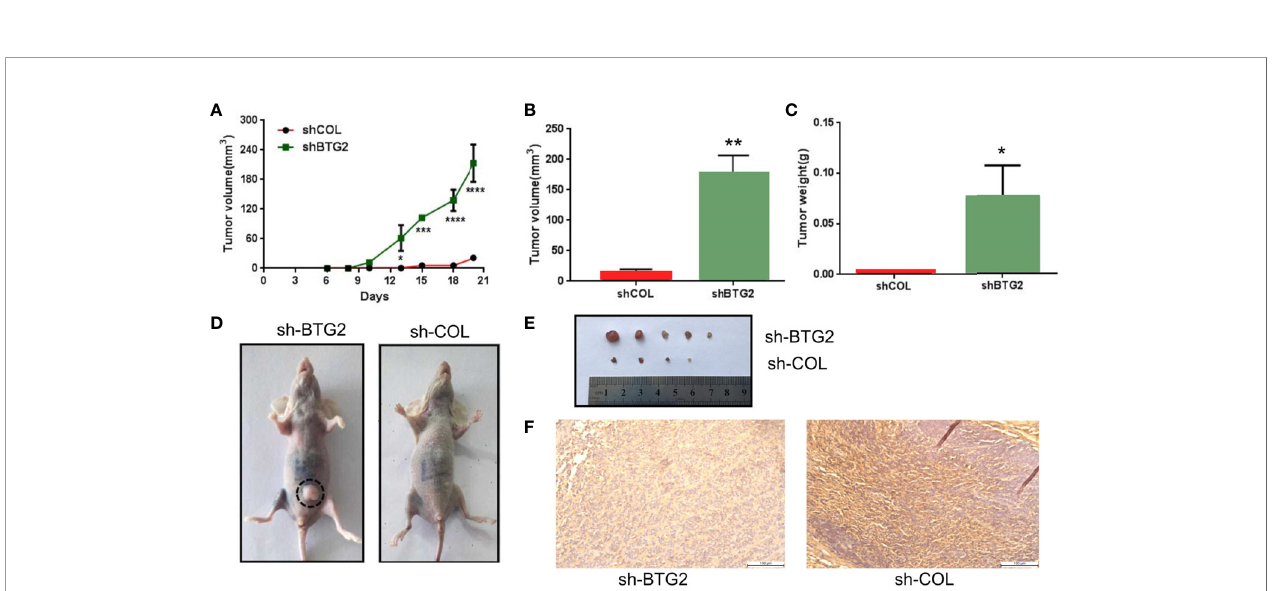
FIGURE 7 | BTG2 suppresses tumorigenicity in vivo and in clinic. (A) Tumor growth curve of BTG2 knockdown tumors (n = 5) and control tumors (n=5). (B) Analysis of tumor volume in BTG2 knockdown group and control group. (C) Analysis of tumor weight in BTG2 knockdown group and control group. (D) Representative images of tumorigenicity assay performed in nude mice. (E) Tumors were obtained from nude mice injected subcutaneously with A2780 cells transfected with sh-BTG2. (F) Immunohistochemistry images of mice tumors in X20 microscope in NC-transfected and shBTG2-transfected mice. *p < 0.05, **p < 0.01, ***p < 0.00, ****p <